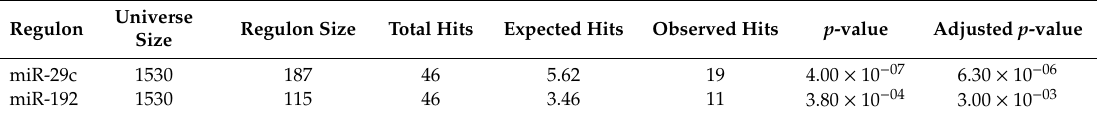
Table 1. Master regulator analysis of miRNAs in the squamous subtype of PDAC (Only showing the miRNAs with the adjusted p -value < 0.01).